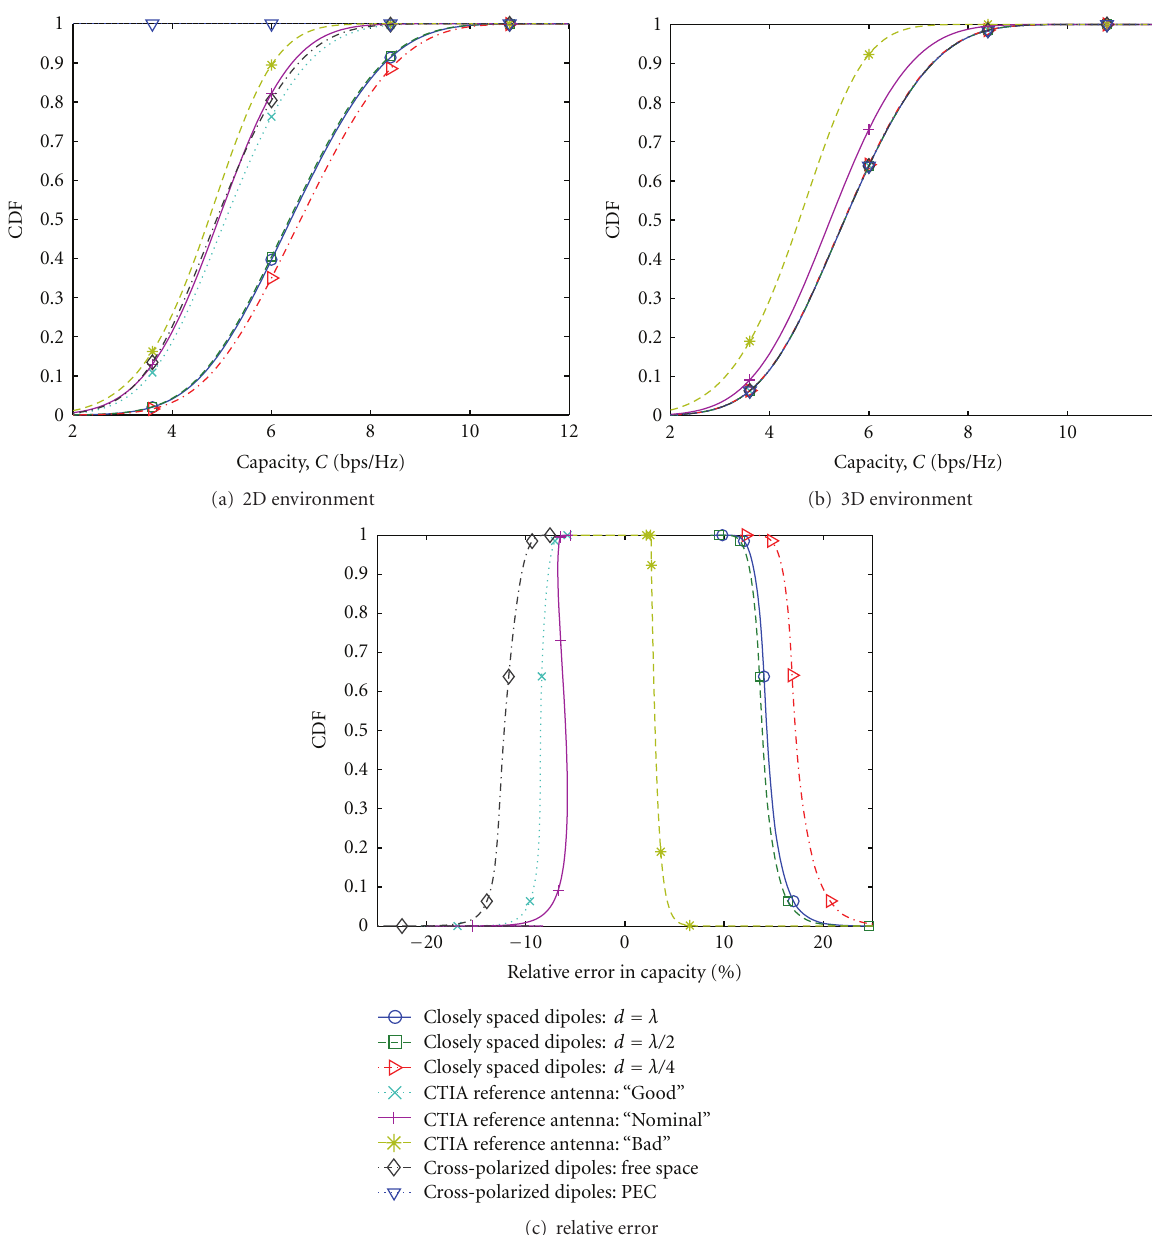
Figure 1: Comparison of the capacity CDFs for the di ff erent AUTs in statistically isotropic environments at a single orientation: (a) capacity CDFs for the 2D environment, (b) capacity CDFs for the 3D environment, (c) relative error in the 2D environment’s capacity CDFs with respect to the 3D environment’s capacity CDFs. The center plot’s legend applies to all three